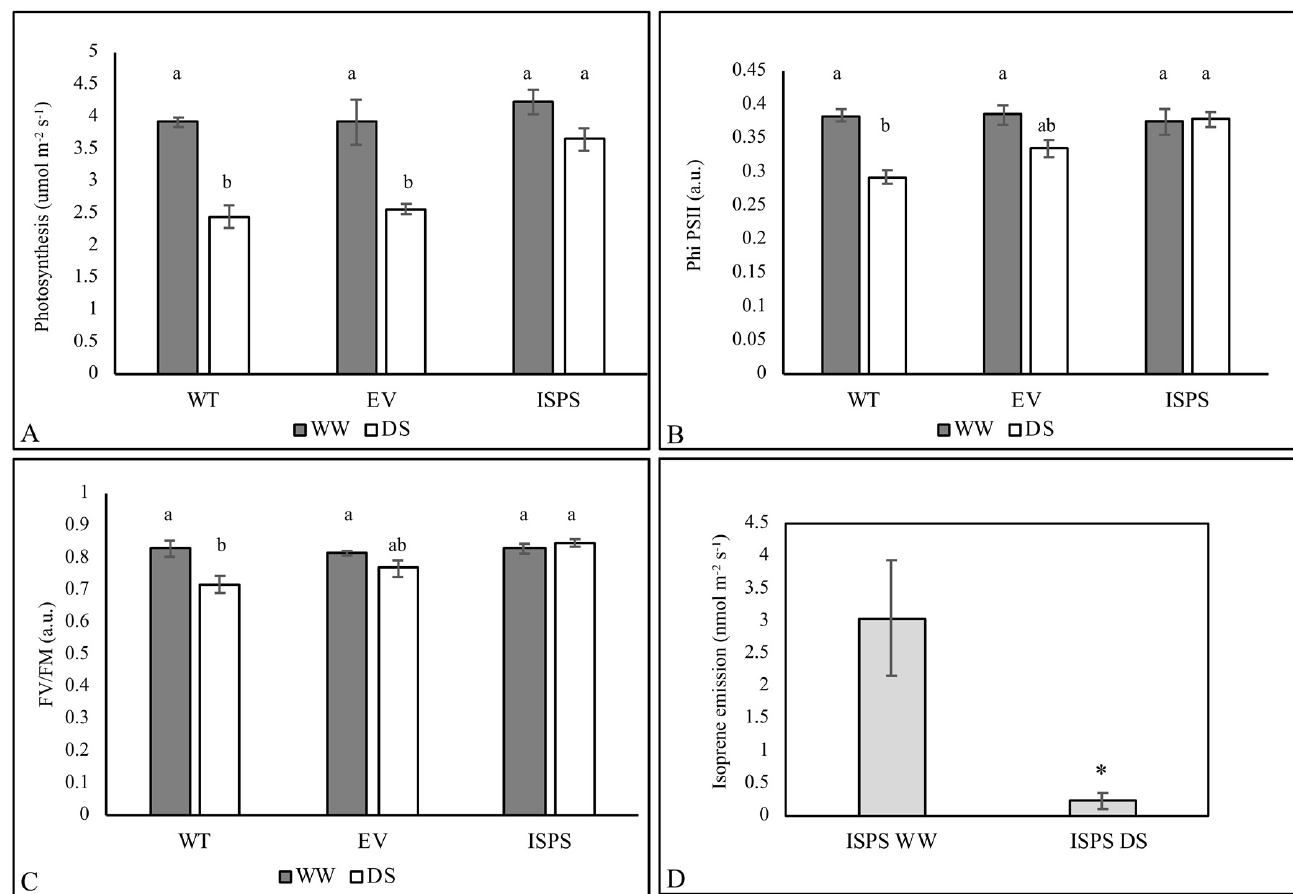
Figure 1. Photosynthesis (An) ( A ), PSII quantum yield ( Φ PSII) ( B ), maximum quantum efficiency of photosystem II (Fv/FM) ( C ) of wild-type (WT), empty vector (EV), and isoprene-emitting (ISPS) plants in well-watered (WW, grey bars) and water-stressed (DS, white bars) conditions. Isoprene emission ( D ) of ISPS plants measured in well-watered and water stressed conditions. Means + SE (n = 5) are shown. One-way ANOVA followed by Tukey’s test was performed to statistically separate means ( A – C ). Means significantly different ( p < 0.05) are represented by different letters (a, b, c). Student t test was applied to compare the isoprene emission in isoprene emitting plants in WW and WS conditions (* p <